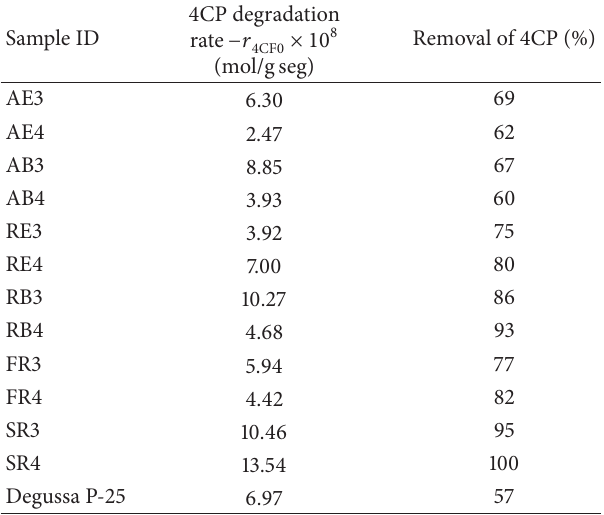
Table 3: Initial reaction rates and removal of 4CP with the titania samples and Degussa